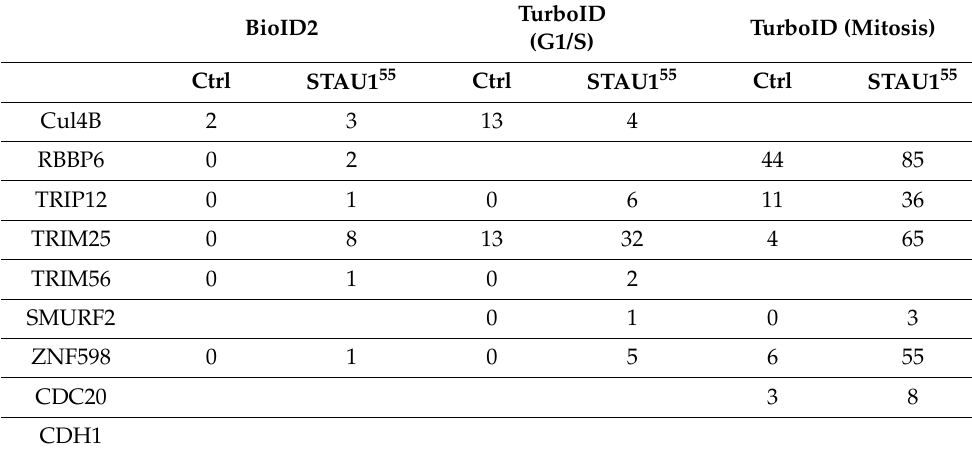
Table 2. List of E3 ubiquitin ligases in the proximity of STAU1 55 . Total spectrum count in differ- ent conditions. TurboID BioID2 TurboID (Mitosis) (G1/S) STAU1 55